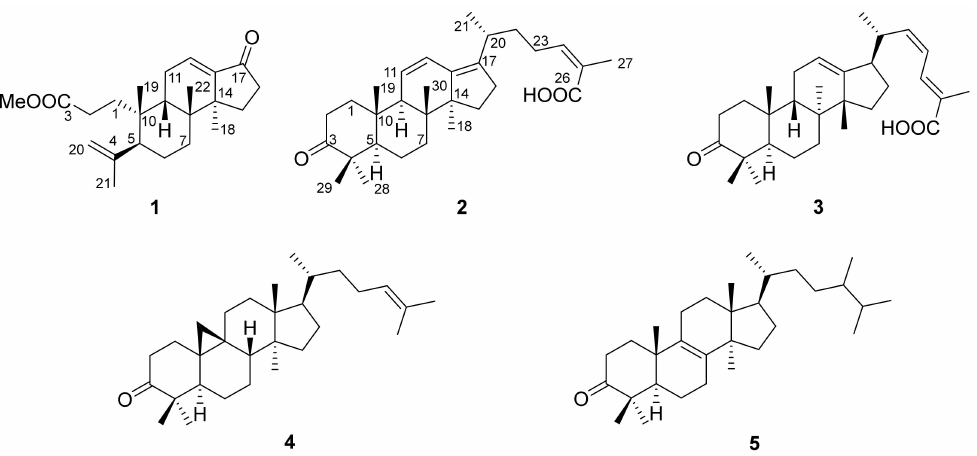
Figure 1. The structures of compounds 1 – 5